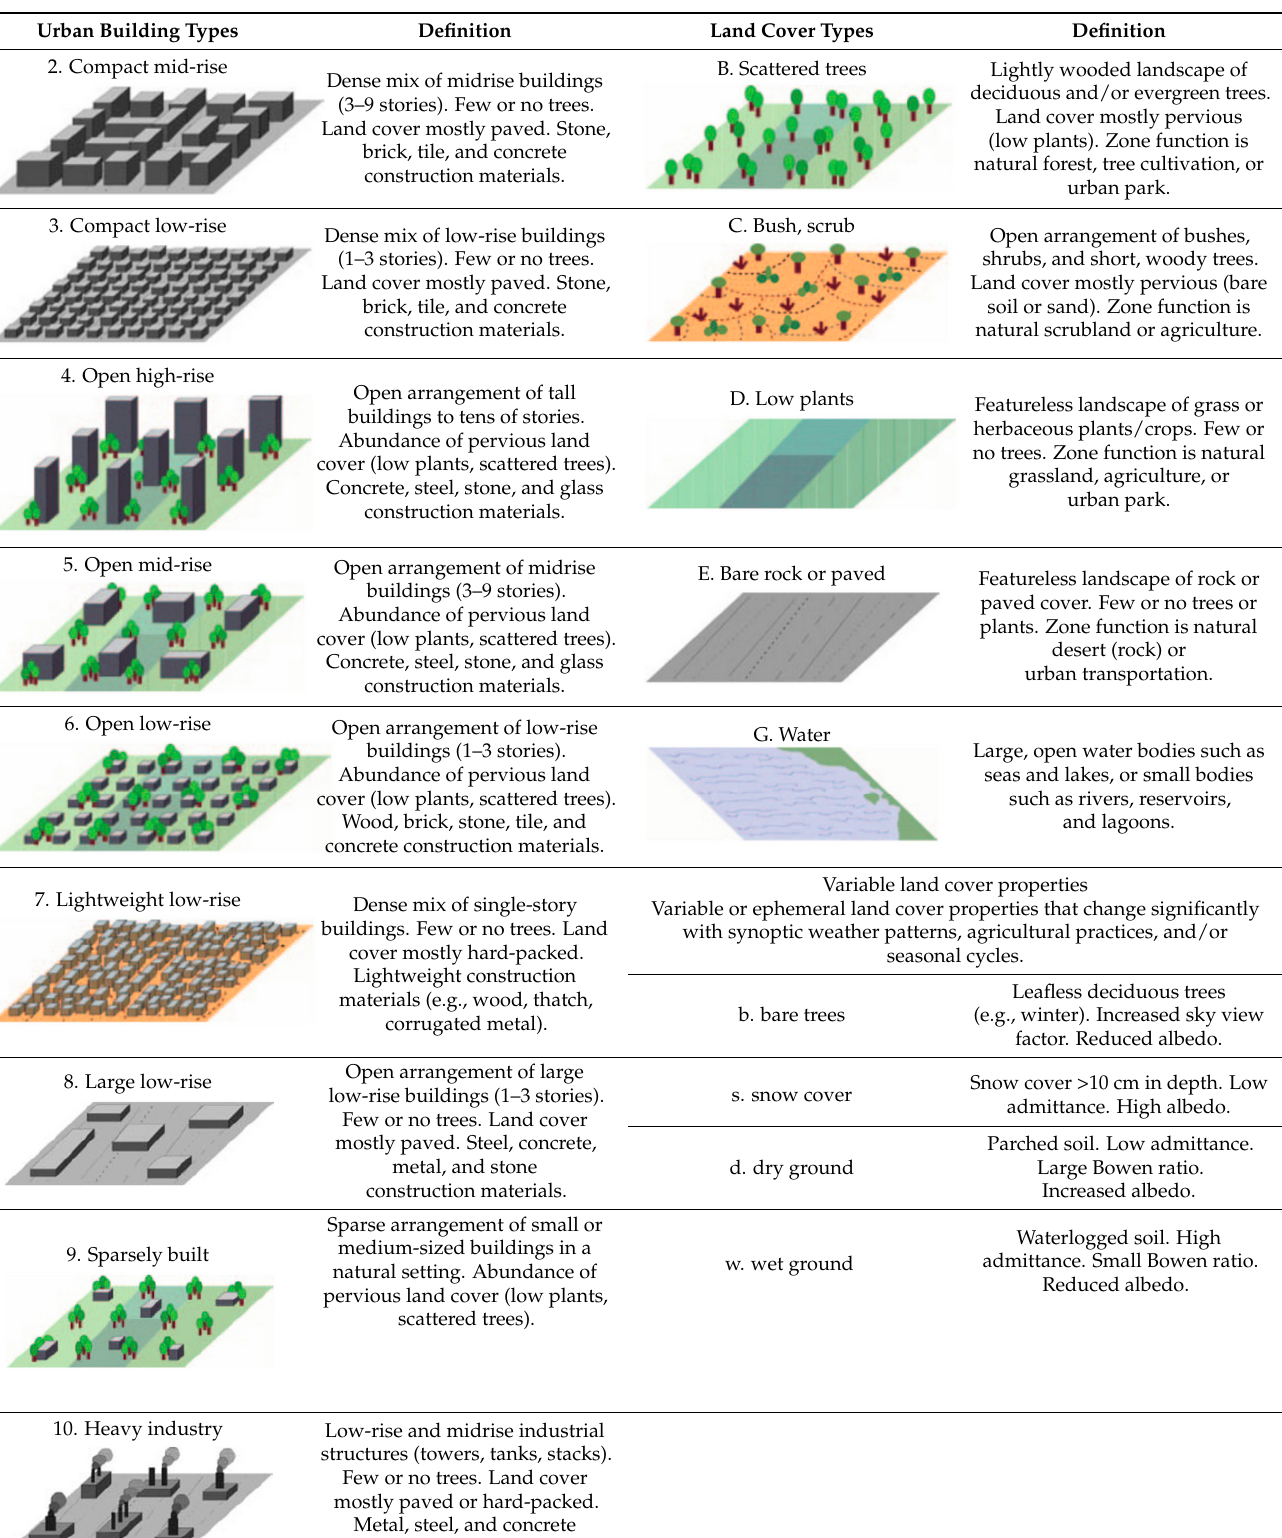
Figure A1. Sentinel-1 data processing flow. References